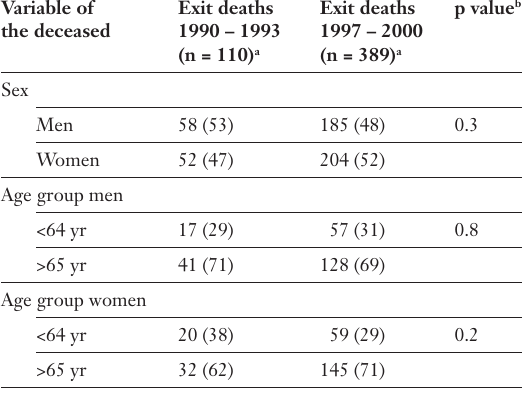
Sociodemographic parameters of Exit deaths (Swiss resi- dents) 1990–1993 and 1997–2000. Figures are numbers (column percentage) of people.